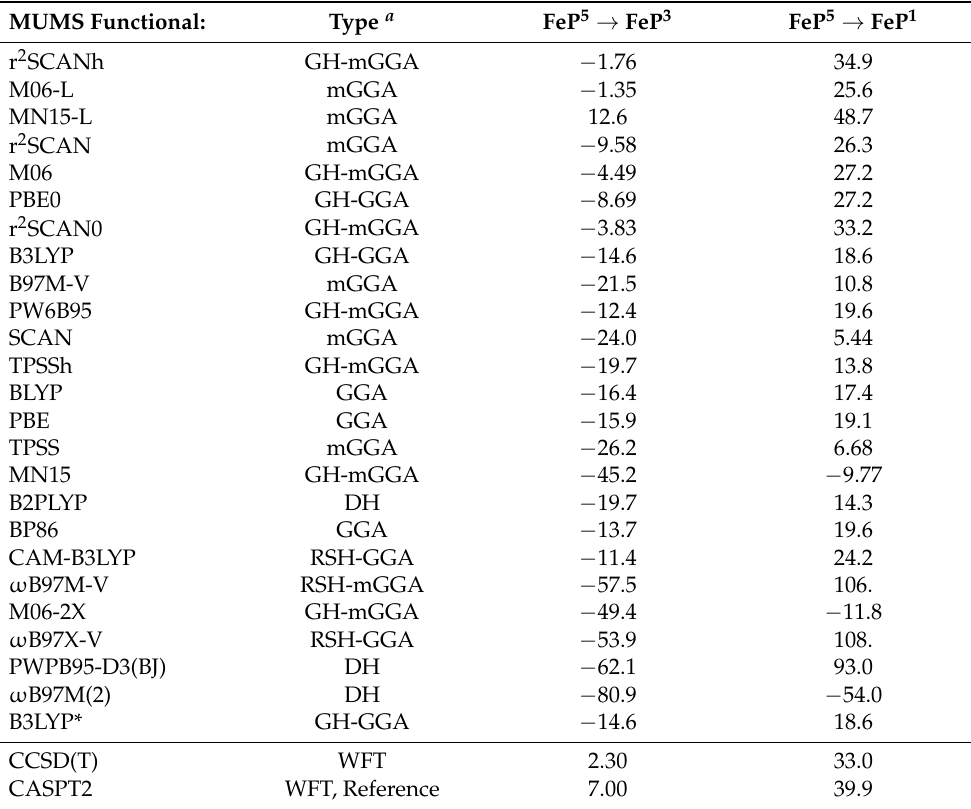
Table 3. Spin state energy differences for the FeP system with 25 of the “most used, most suggested” (MUMS) functionals in the literature. All values are in kcal/mol. WFT = Wavefunction theory. MUMS